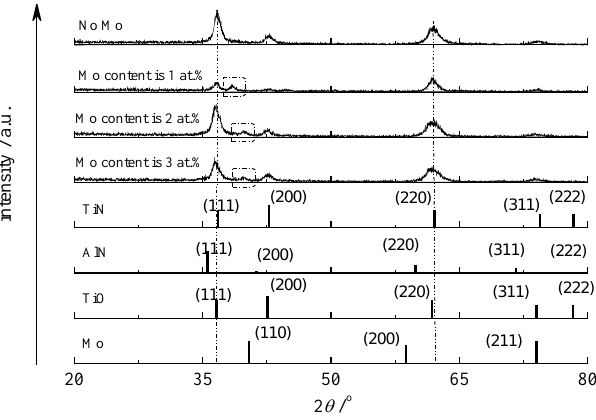
Figure 6. Effect of Mo content on phase constitution of TiMoAlON films.